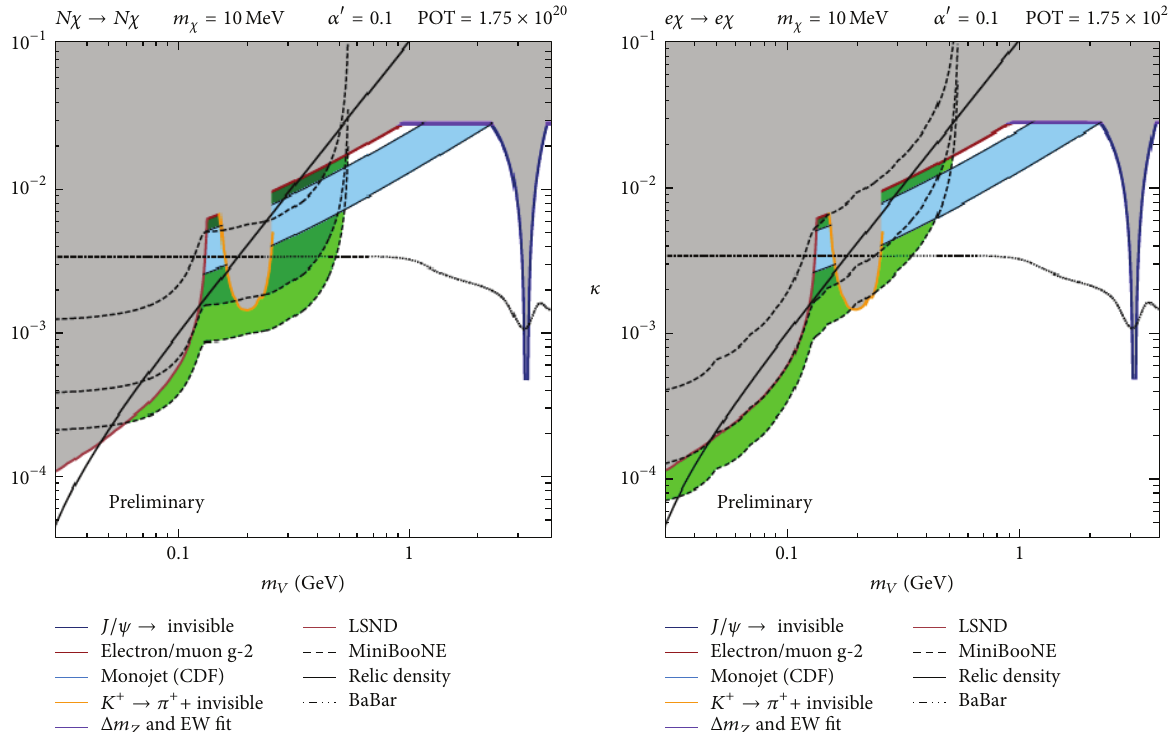
Figure 16: (Color online) The MiniBooNE dark matter search phase space [116]. Here, 𝑥 -axis is the vector mediator mass 𝑚 𝑉 , and the 𝑦 -axis is the kinetic mixing parameter 𝜅 , assuming the dark matter mass and the gauge coupling ( 𝑚 𝜒 = 10 MeV and 𝛼 = 0.1 ). MiniBooNE exclusion region can be seen in